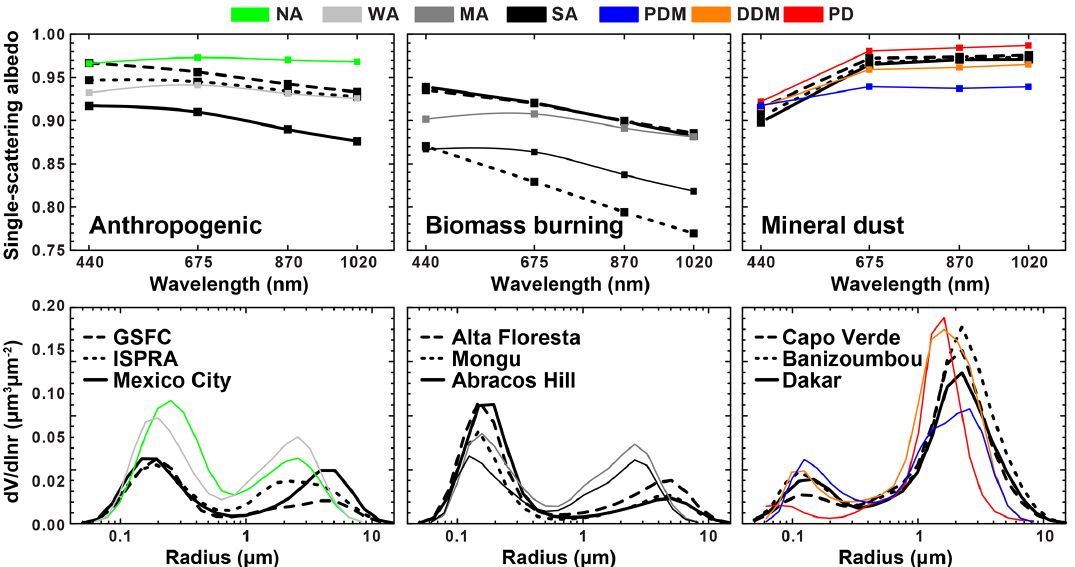
Figure 7. Mean spectral SSA (upper row) and mean particle size distributions (lower row) for AERONET sites that are considered to be representative for different aerosol types as well as for the aerosol types defined in this study (see Fig. 3 for colour coding). Note that the size distribution for pure mineral dust (red line) has been scaled to 50% to fit the